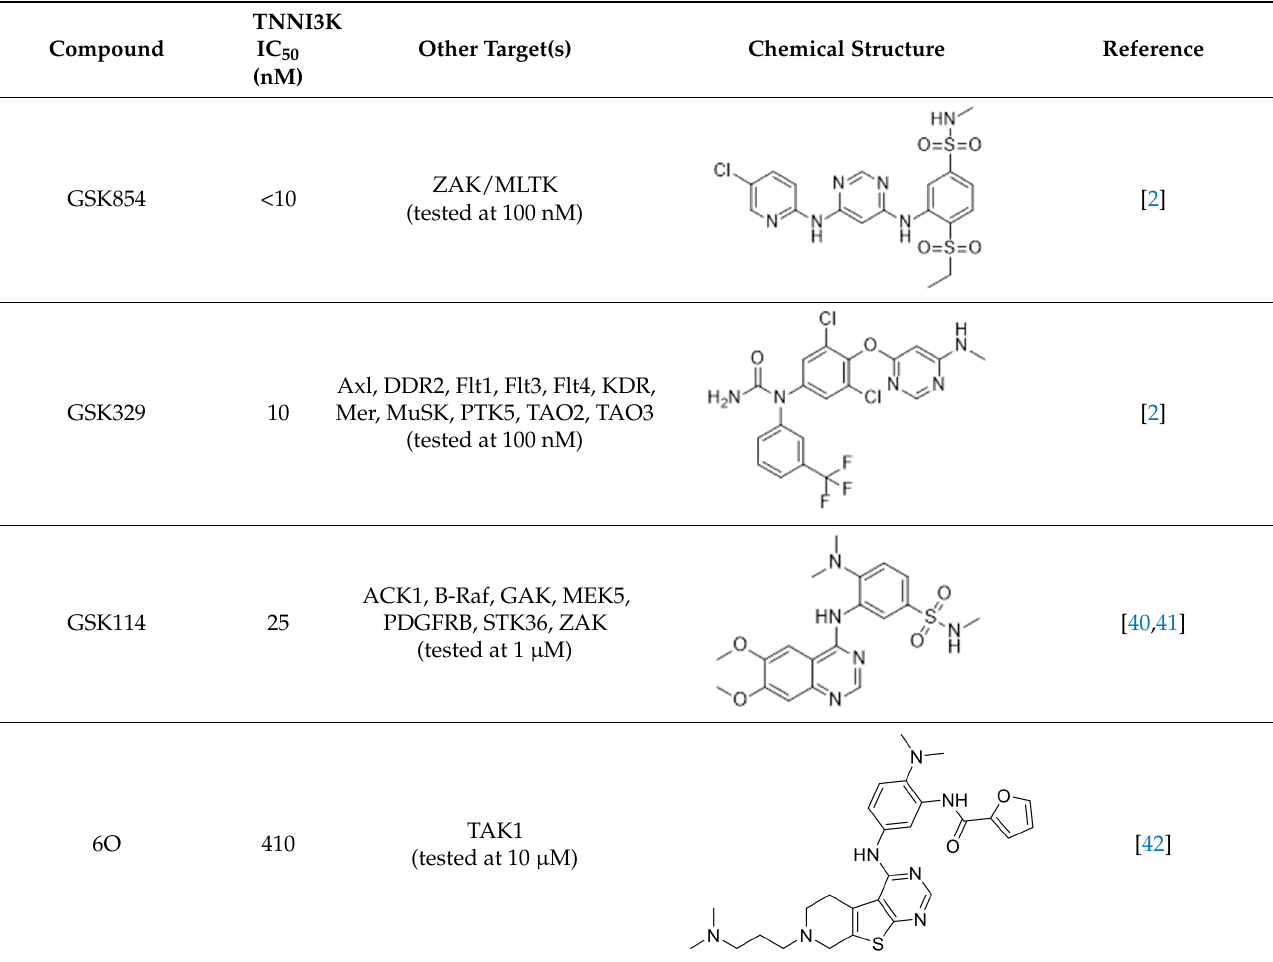
Table 2. TNNI3K inhibitors.